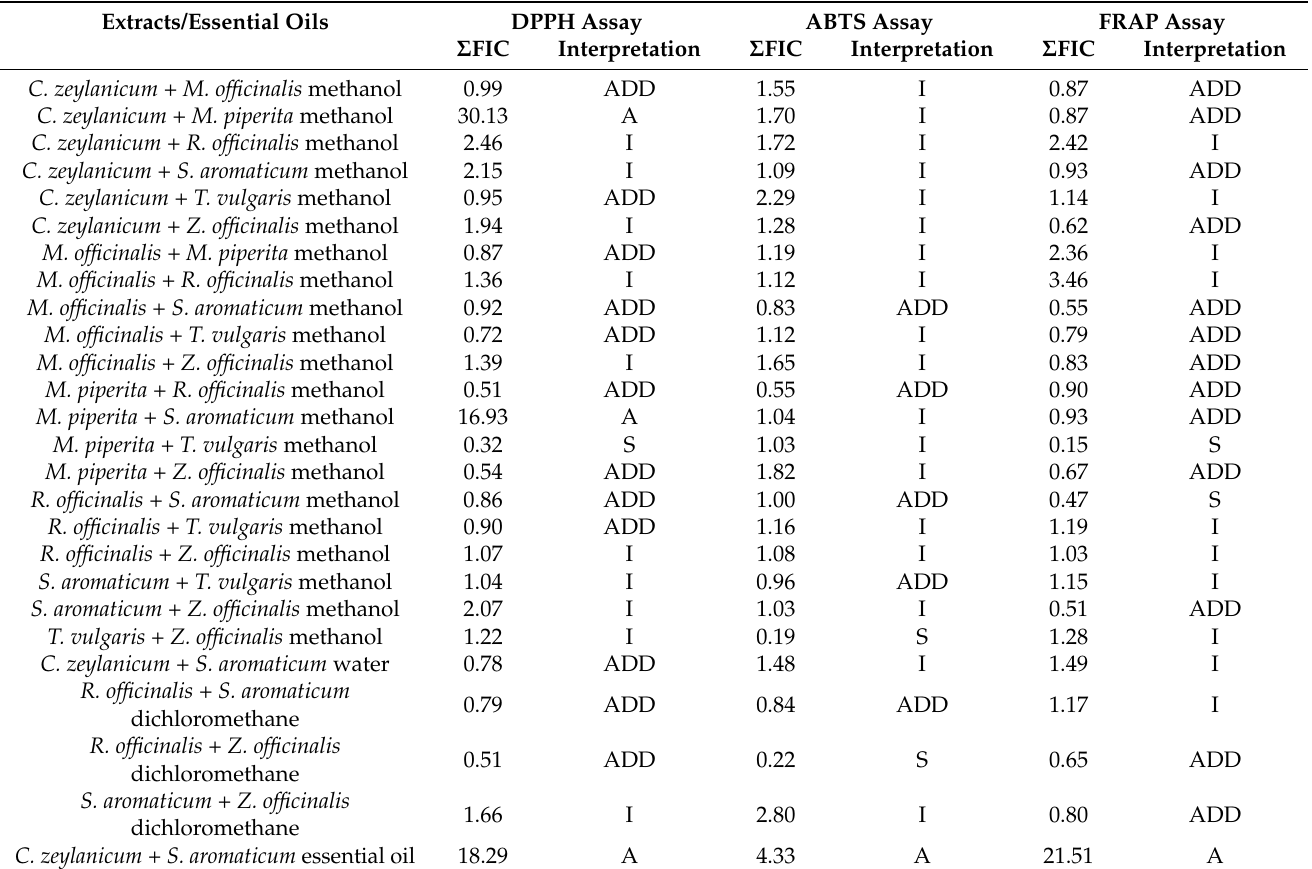
Table 3. Antioxidant effects from the combinations (1:1 v / v ) of active extracts and essential oils with the DPPH, ABTS, and FRAP